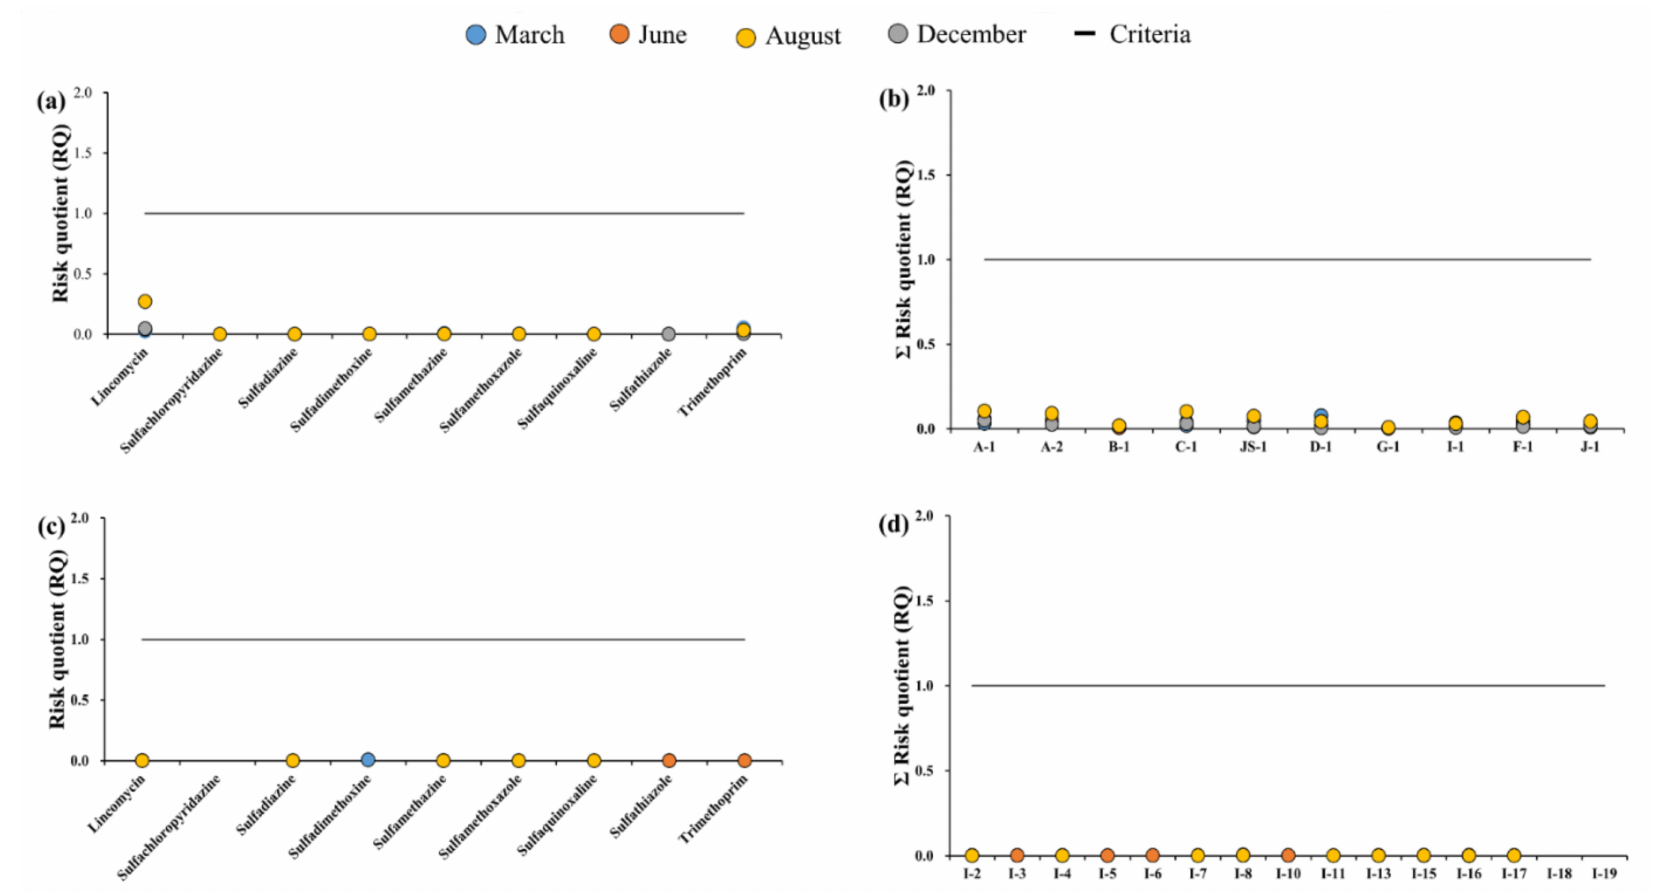
Figure A2. Risk assessment of antibiotic resistance by sampling time for surface water samples: ( a ) target antibiotics, and ( b ) sampling points; assessment for groundwater samples: ( c ) target antibiotics, and ( d ) sampling